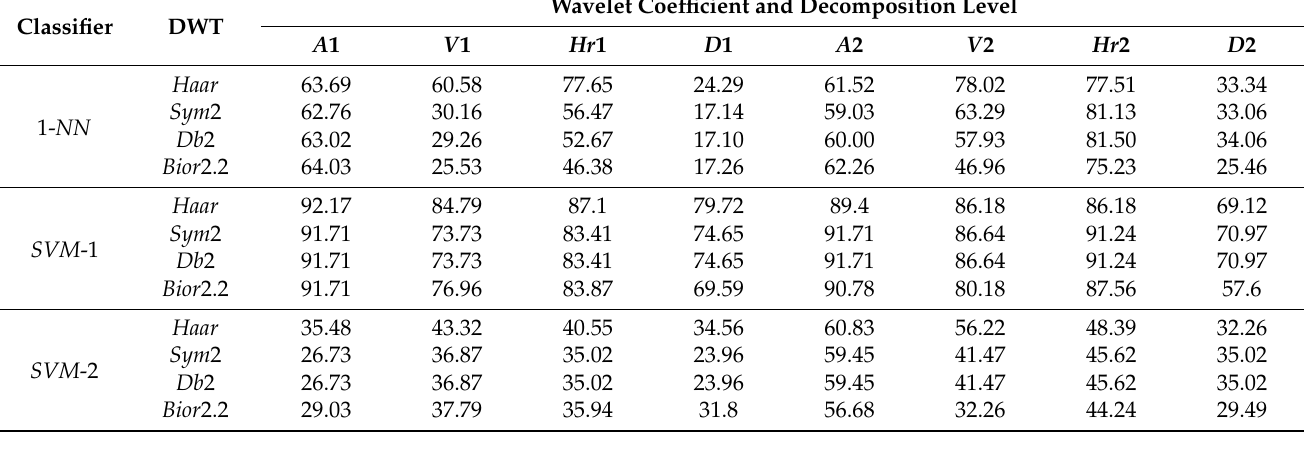
Table 9. The accuracy (%) results of the DWT on the EYB dataset for the eyebrow images. The performance was calculated for all wavelet coefficients in two decomposition levels, producing A 1,